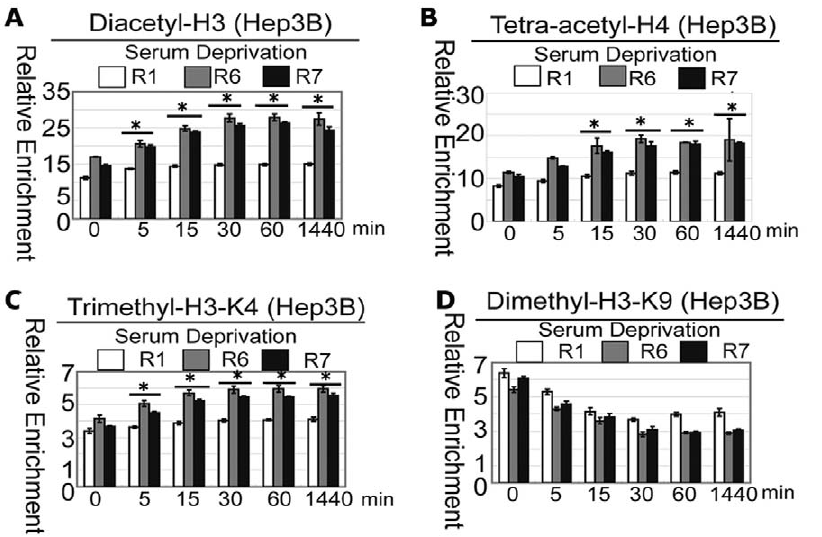
Figure 4. Serum deprivation induces changes in histone modification at the DRAM promoter locus in Hep3B cells. Hep3B cells were prepared for chromatin IP (ChIP) assays. The chromatin DNAs were immunoprecipitated with antibodies specific to H3K4me3 (A), anti-di-acetyl-H3 (B), anti-H3K9me2 (C) and anti-tetra-acetyl-H4 (D), and the enriched DNA fragments flanking the DRAM promoter were analyzed by quantitative PCR. Data were presented as the amount of DNA recovered by specific antibodies relative to DNA enriched by the appropriate IgG controls. The results were expressed as the means 6 standard deviations of three independent experiments. *: P , 0.05.